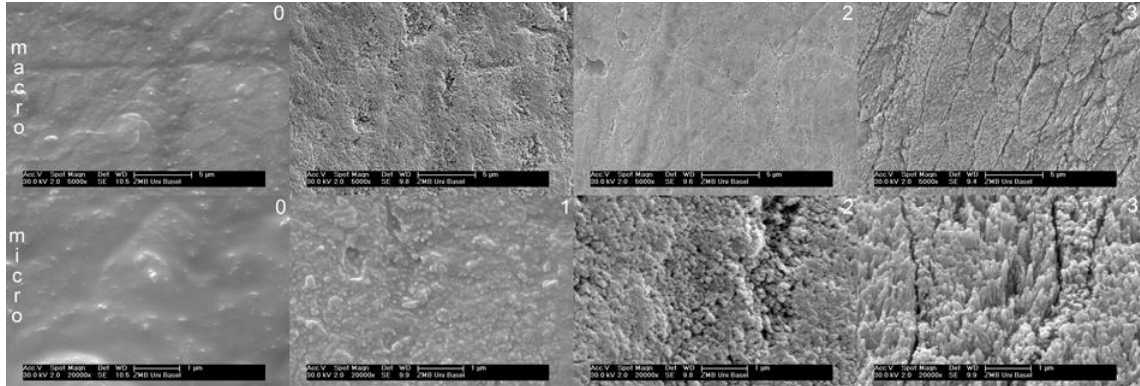
Figure 1. SEM images representing the visual four point grading system. Upper row: macroscopic grades 0 – 3. Lower row: microscopic grades 0 – 3.